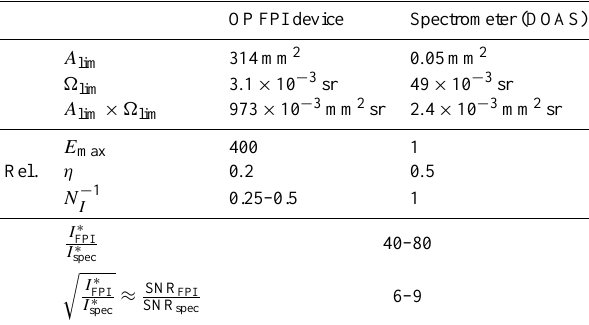
Table 2. Comparision of the OP FPI camera and a spectrometer used in DOAS measurements (Ocean Optics © USB 2000+), when observing the same spectral range: the surface area A lim and the solid angle (cid:127) lim limiting the etendue E max mainly contribute to the 6–9 times higher SNR of the OP FPI camera.